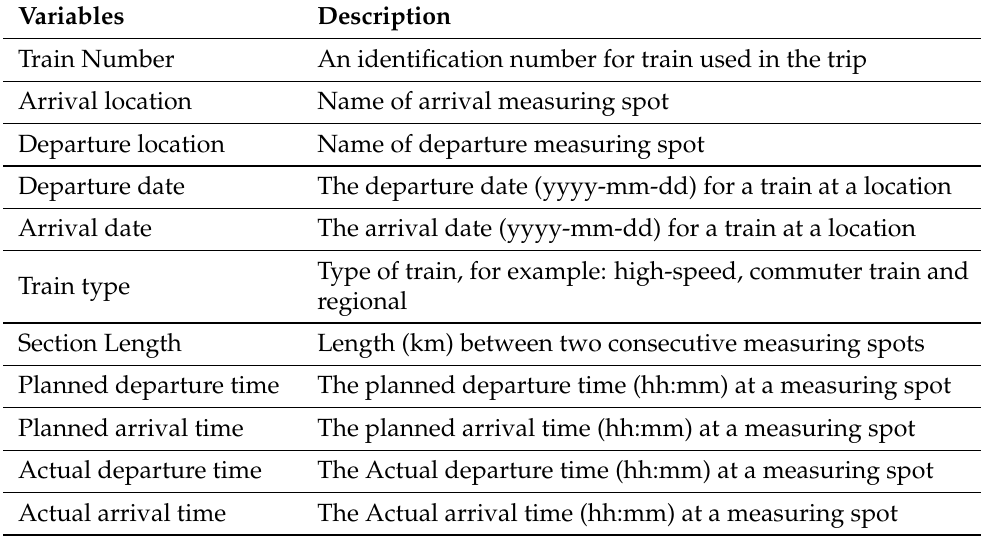
Table 1. List of variables in the train operation